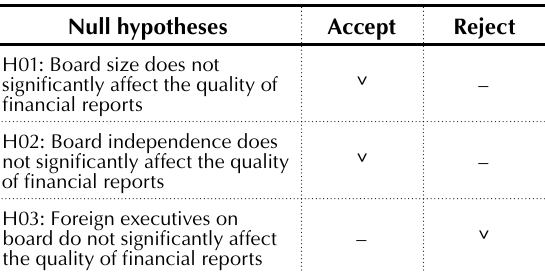
Table 5. Analysis of null